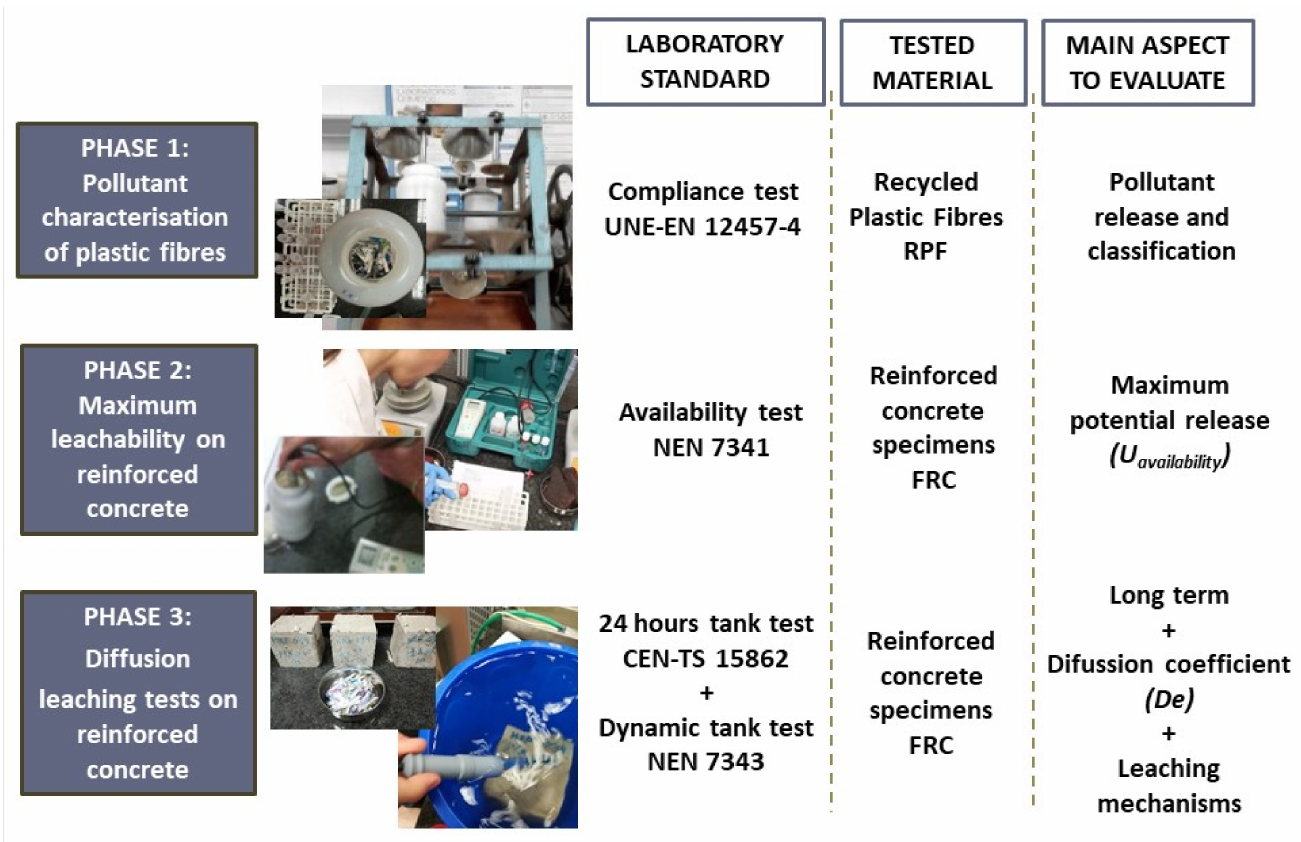
Figure 3. Phases of the experimental procedure for leaching assessment of FRC made with